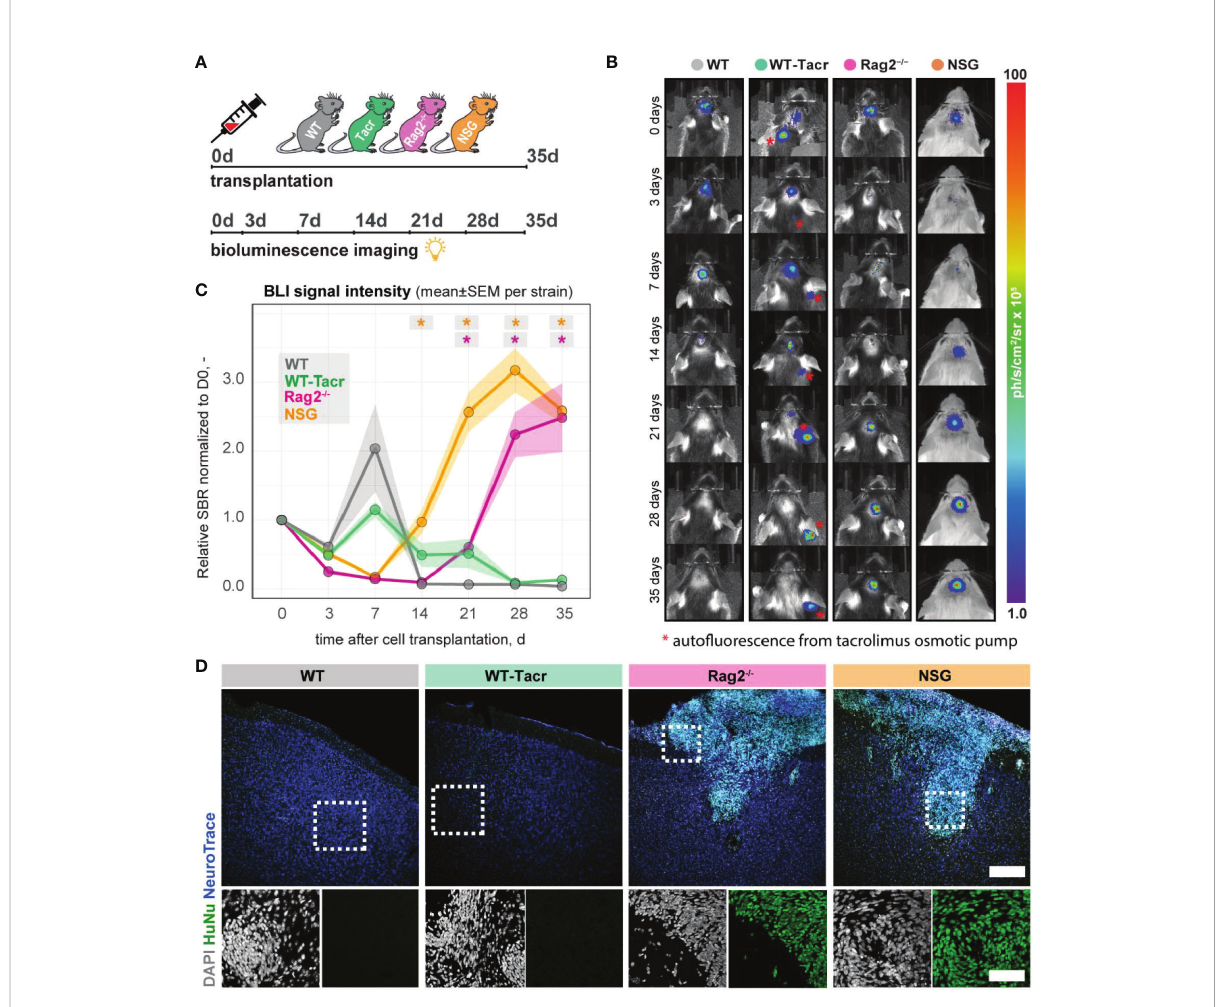
FIGURE 8 In vivo tracking of transplanted NPCs in immunode fi cient mouse models. (A) Schematic overview of experimental time course (B) Representative bioluminescence images of luciferase-expressing NPCs transplanted in immunode fi cient and WT mouse models at 0, 3, 7, 14, 21, 28, 35 days after transplantation. (C) Bioluminescence signal intensity over time after transplantation. (D) Representative images of transplanted human NPCs 35 days after transplantation stained with anti-human nuclei antibody (HuNu, green), NeuroTrace ( fl uorescent Nissl, blue) and counterstained with DAPI (grey). Scale bar: 50 um. Line graphs are plotted as mean ± sem. d, days; BLI, bioluminescence imaging; sbr = signal background ratio; ph, photons; sr, steradian. *P <